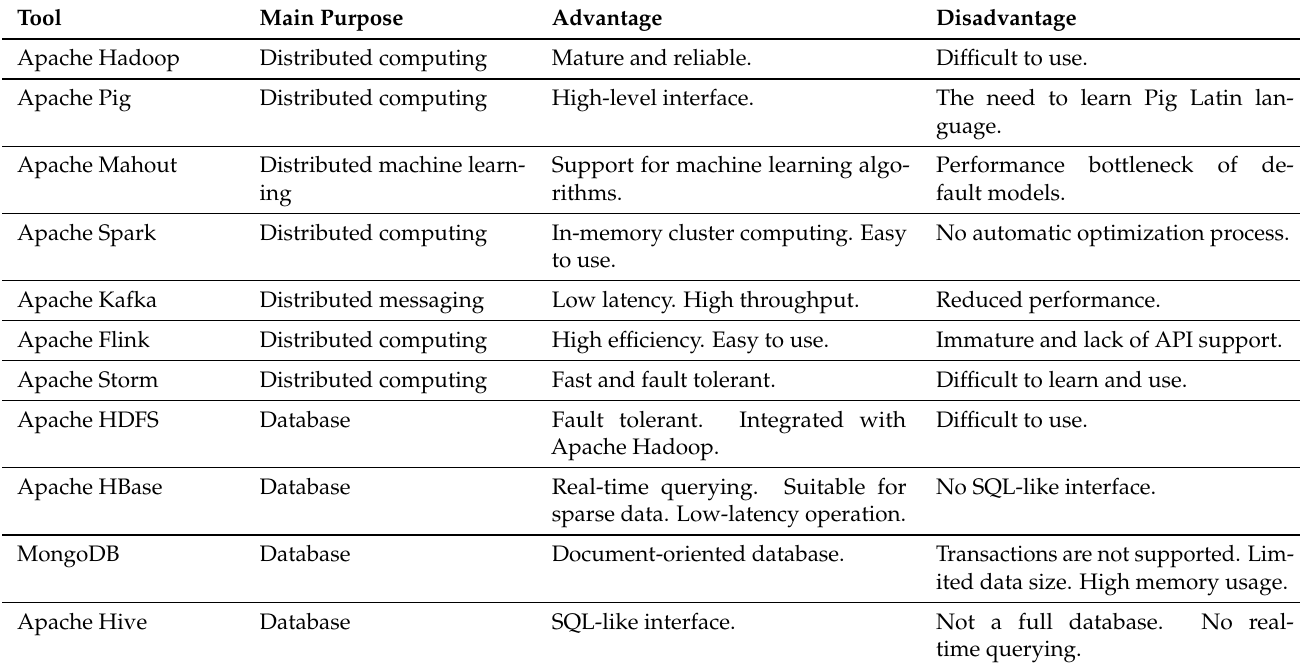
Table 10. A comparison of big data